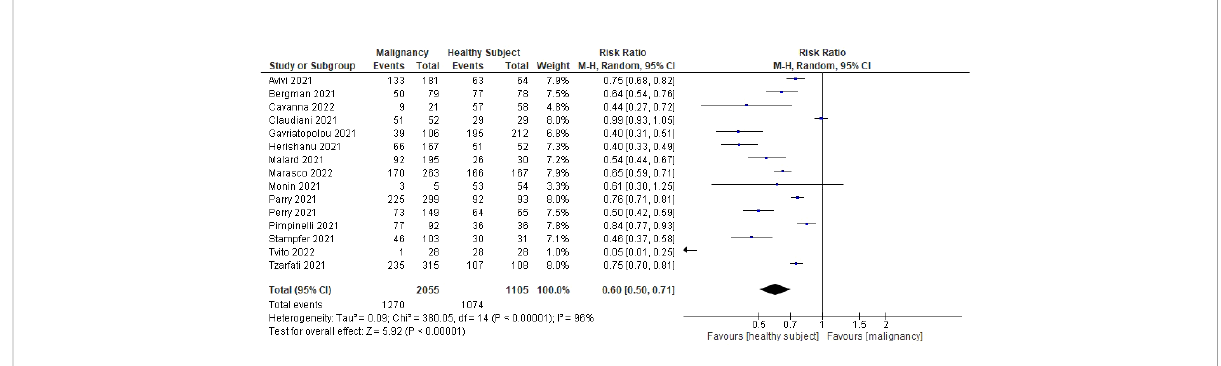
FIGURE 2 Forrest plot for the seroconversion rate after two doses of COVID-19 mRNA